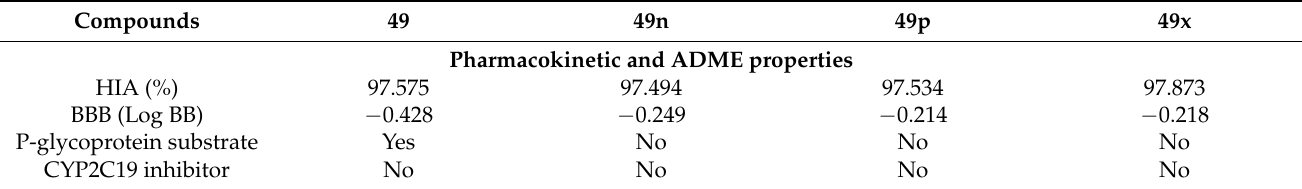
Table 8. ADMET properties for the designed compounds and the reference